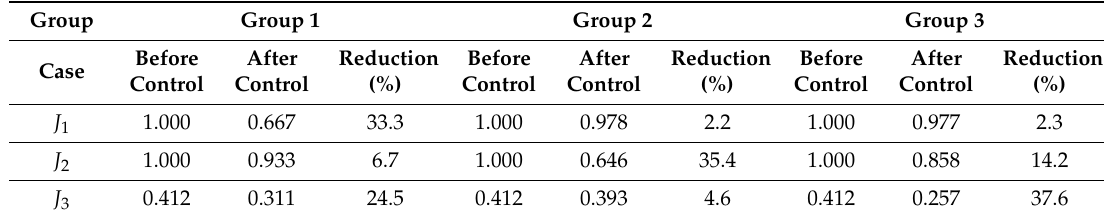
Table 3. Sensitivity analysis of objectives versus weightings.